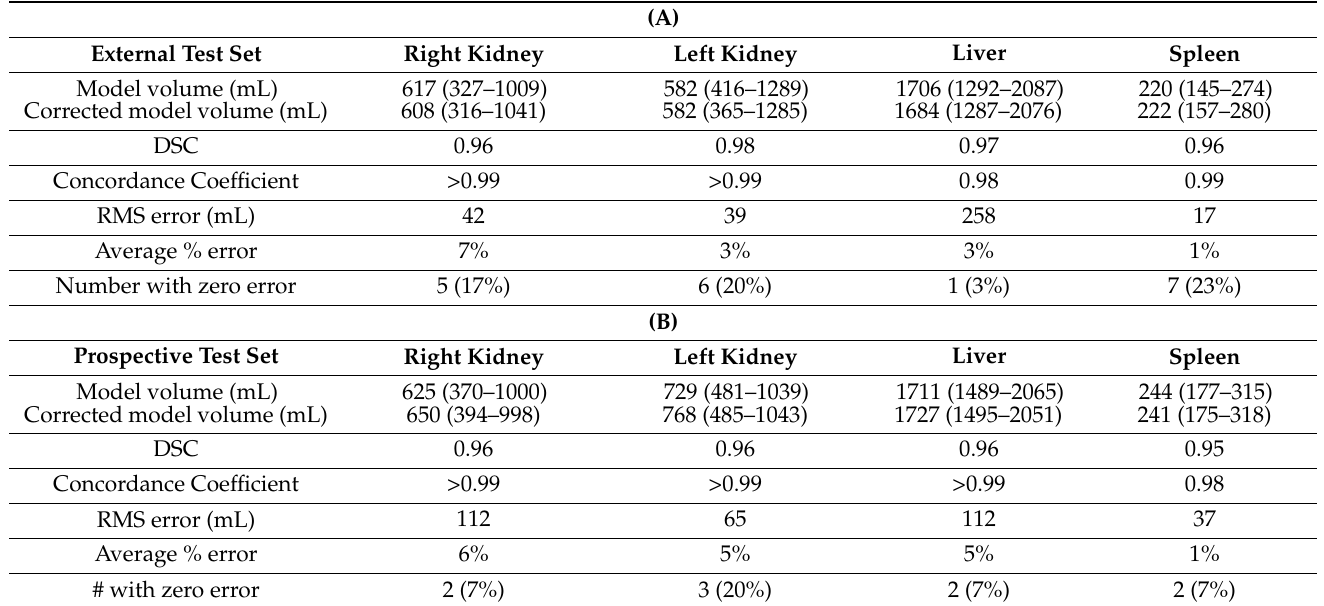
Table 3. ( A ) Model accuracy on external validation (n = 30), median (interquartile range). ( B ) Model accuracy on prospective validation (n = 30), median